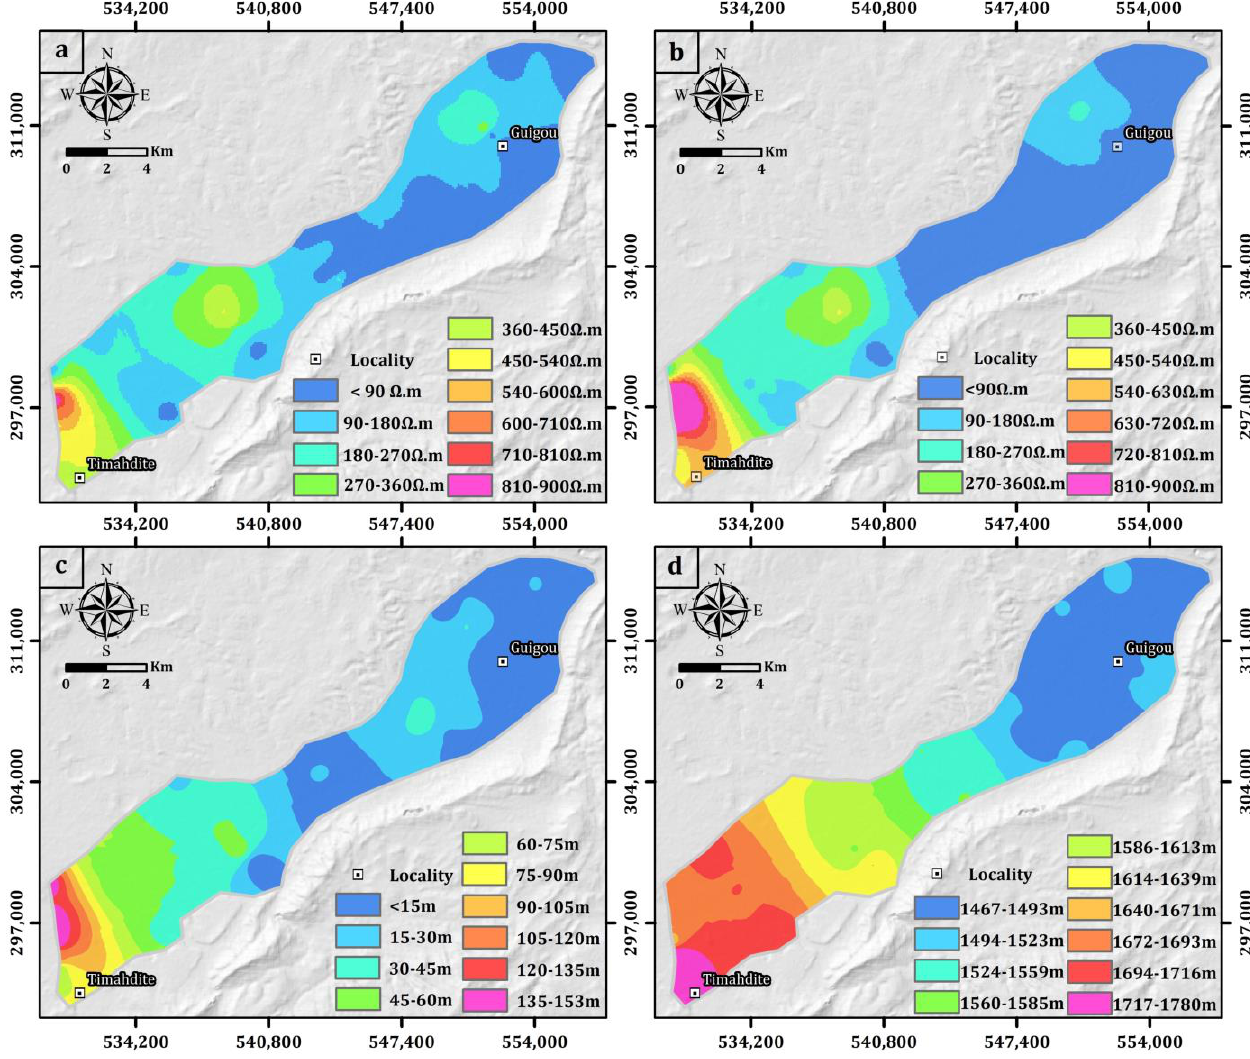
Figure 10. Thematic maps: ( a ): Apparent resistivity map for AB = 80 m ( b ): Apparent resistivity map for AB = 200 m ( c ): Isohypse map of the bedrock of marl and limestone ( d ): Map of Quaternary basalt isopach.